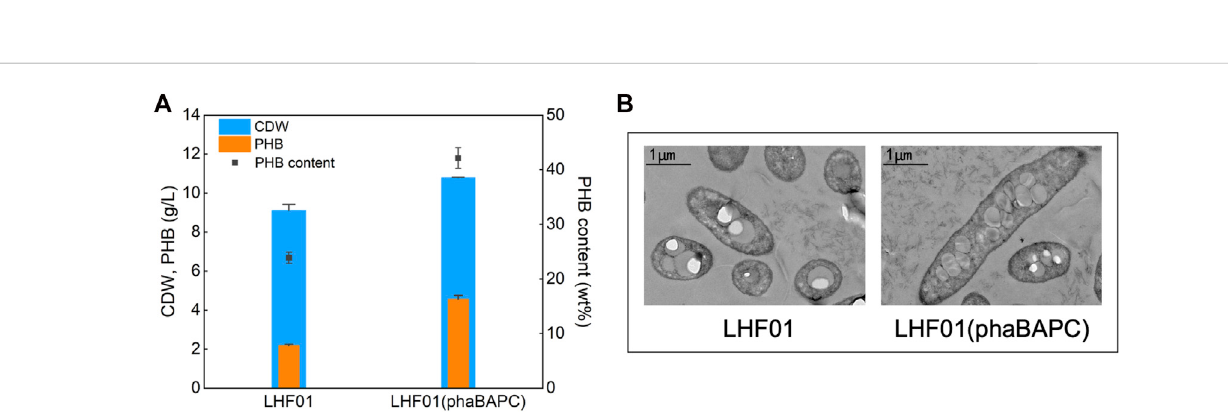
FIGURE 4 EffectsofoverexpressingPHBsynthesisoperononPHBproduction.StrainswerecultivatedinTYS50mediumsupplementedwith20